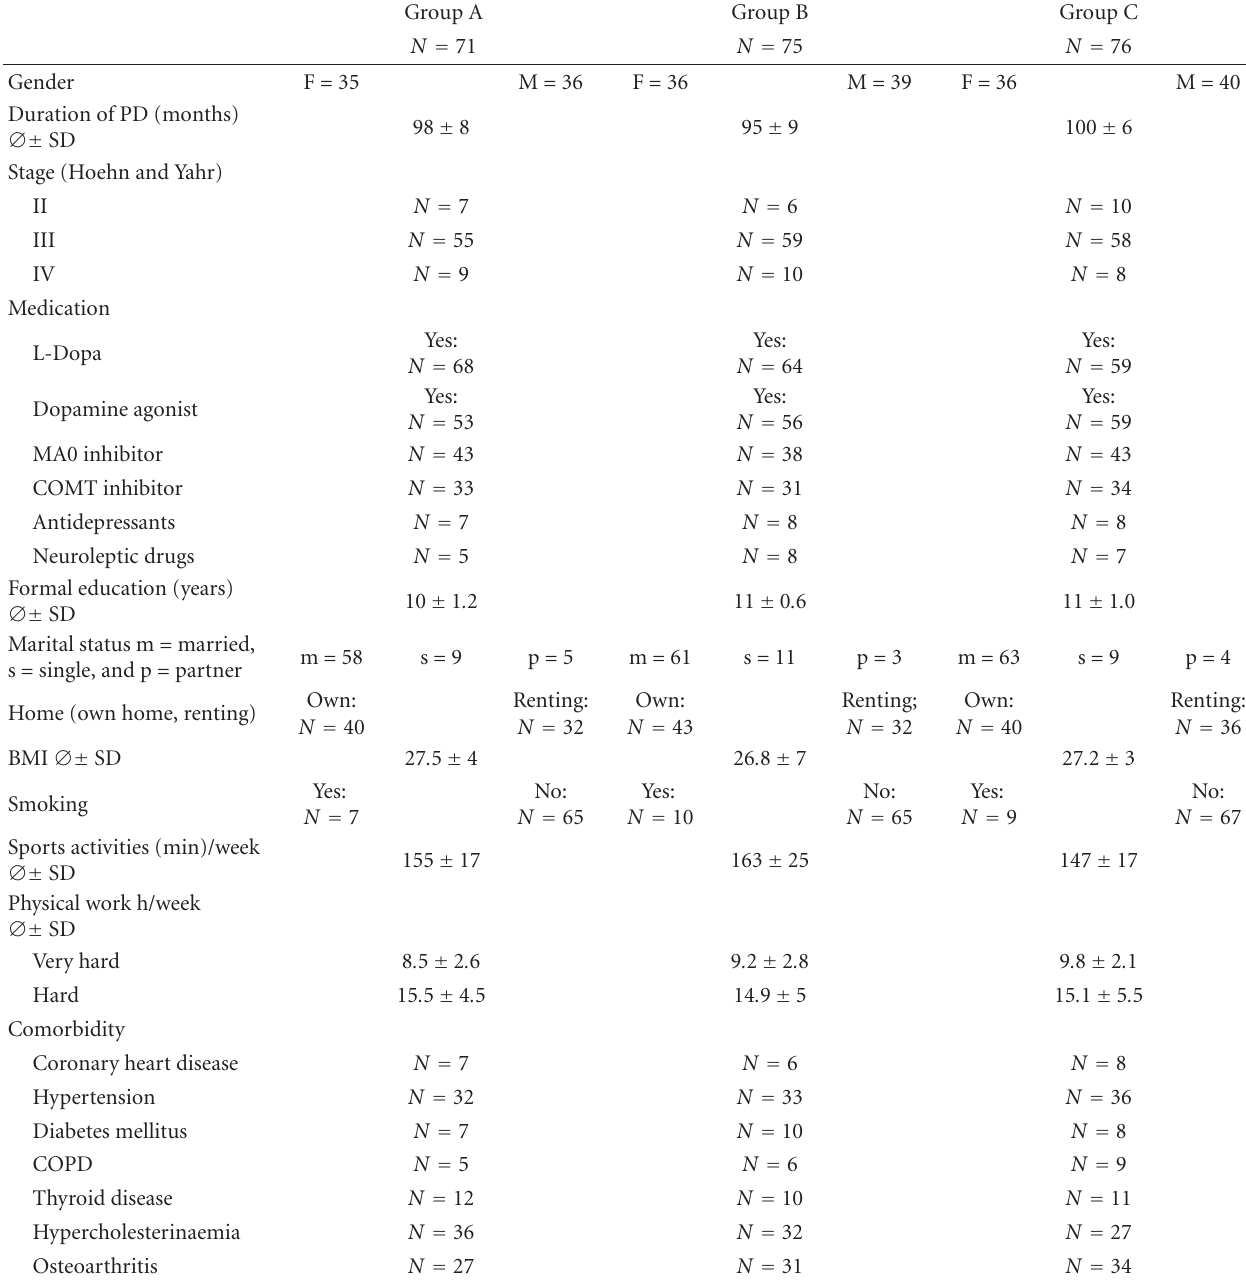
Table 3: Demographic